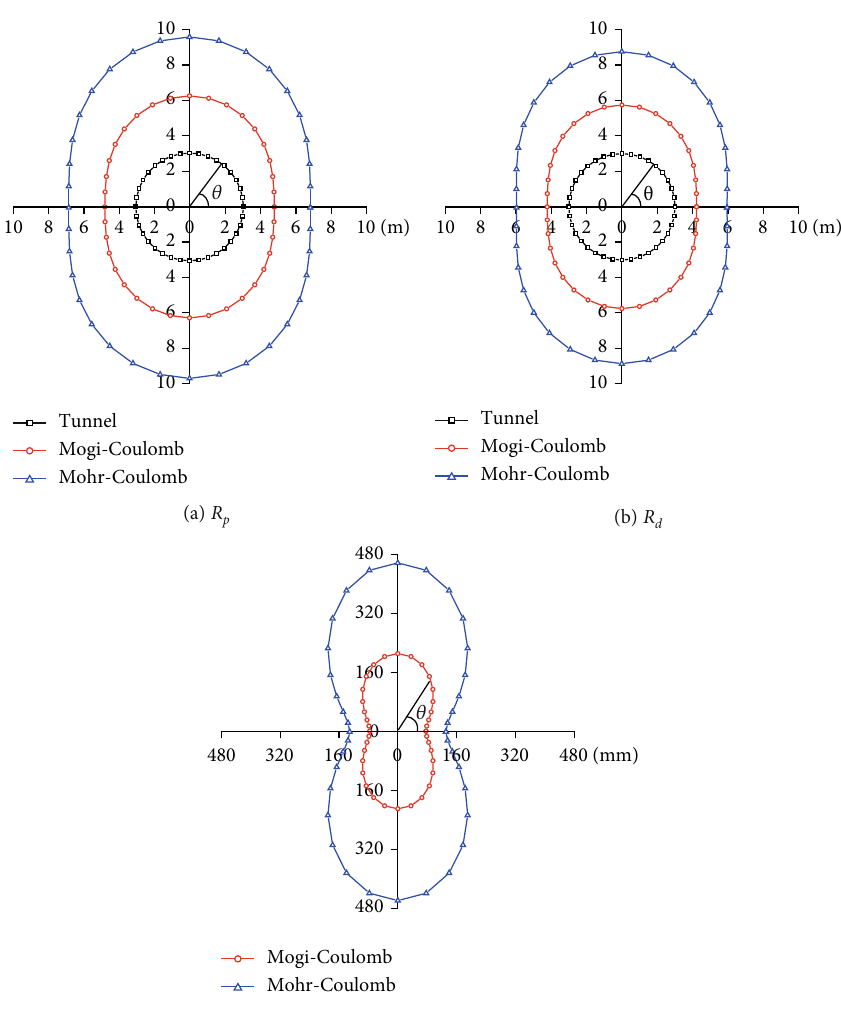
Figure 7: Postpeak zone radii and surface displacement around the tunnel under di ff erent strength criteria.